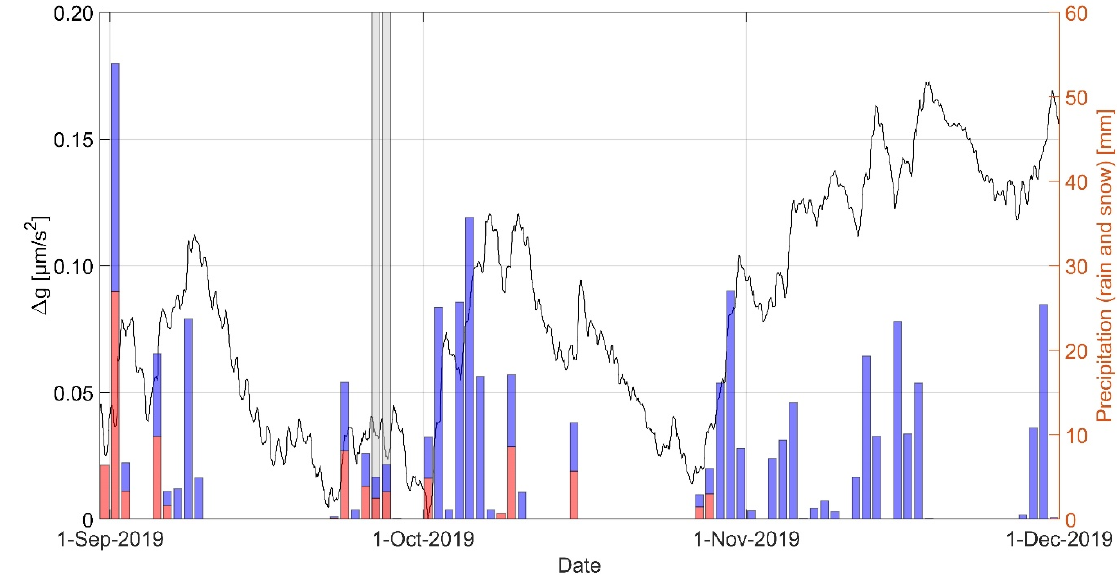
Figure 6. Continuous gravity residuals [ μ m/s 2 ] from OSG#052 at ZUGOG (black), days of absolute gravity measurements (grey) and daily precipitation heights [mm] in terms of rain (red) and snow (blue) at the DWD station Zugspitze.